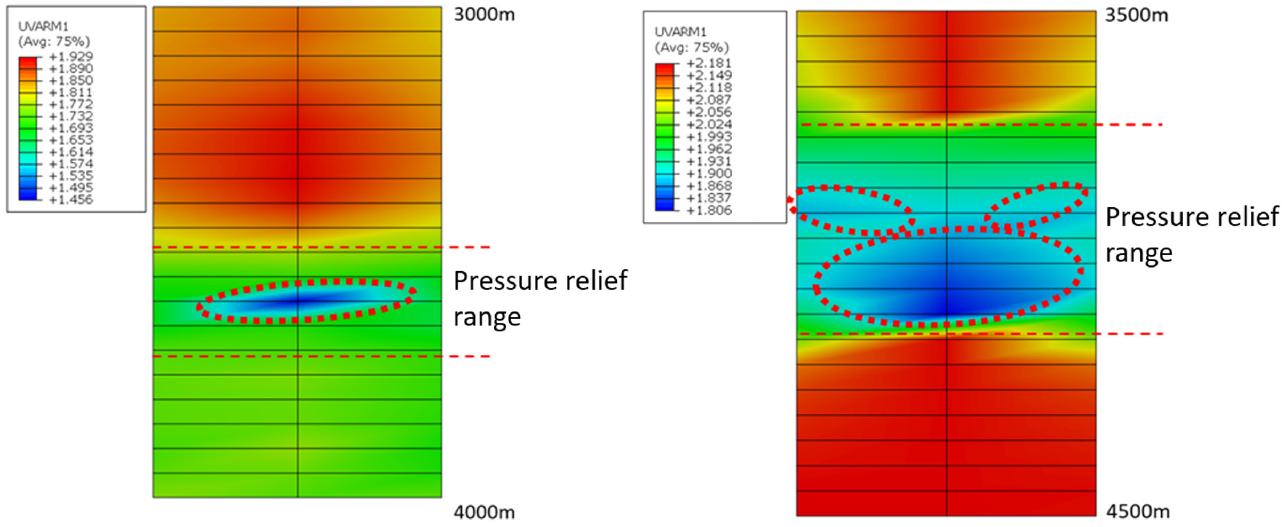
Figure 9. Pressure relief area around wells X-3 and